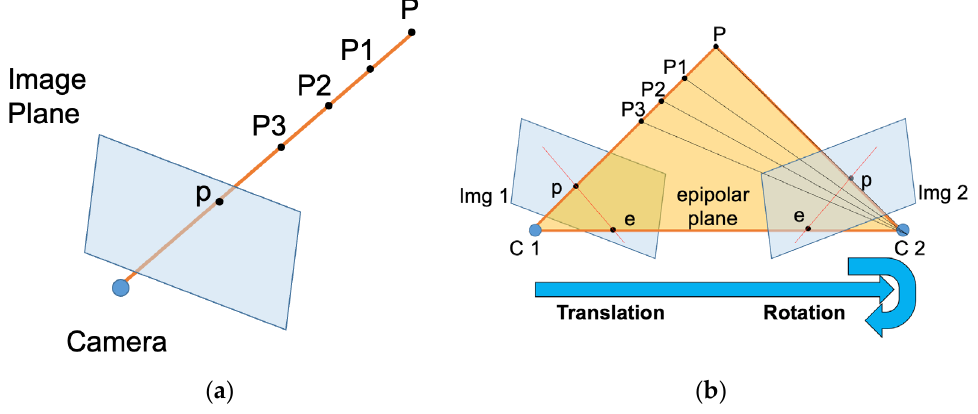
Figure 5. Epipolar geometry. ( a ) one view characterized by one camera position and one image capturing real world point from on point of view. ( b ) two-view characterized by two camera positions, two images capturing the same target from different looking angle.